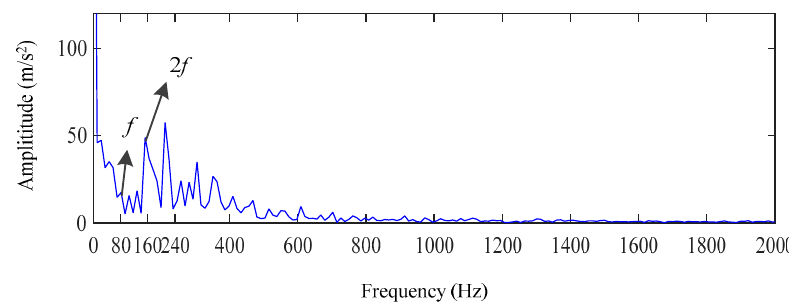
Figure 13. Envelope spectrum of optimal component by using VMD.